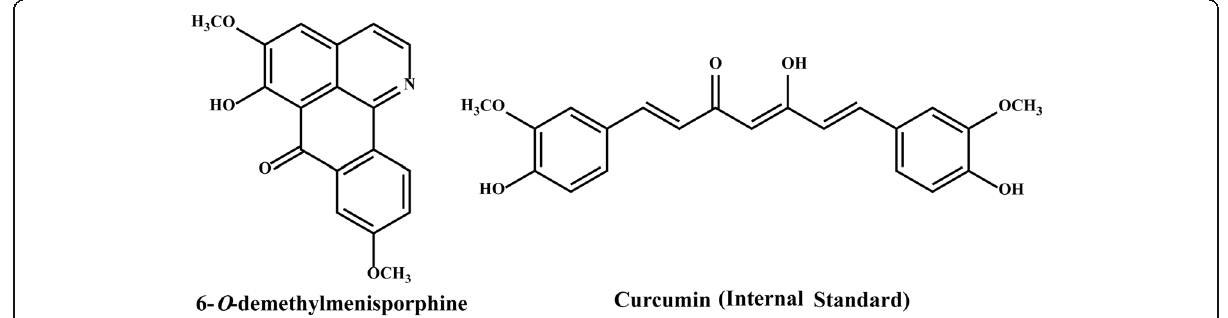
Fig. 1 Chemical structures of 6- O -demethylmenisporphine and curcumin